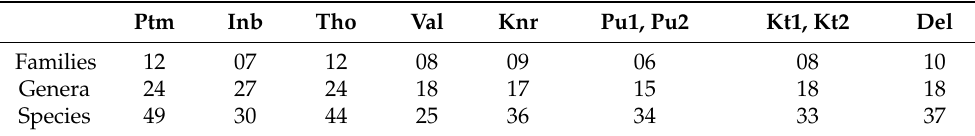
Table 2. Numbers of families, genera, and species of scleractinian corals recorded in each of the eight reef areas studied around the Jaffna Peninsula, Sri Lanka. Ptm Inb Tho Val Knr Pu1, Pu2 Kt1, Kt2